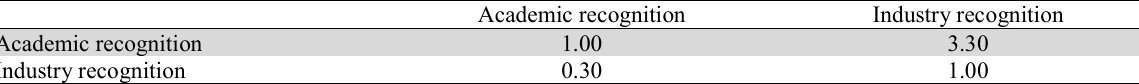
Comparison matrix for comparing the sub-factors of “social recognition” Academic recognition Industry recognition Academic recognition 1.00 3.30 Industry recognition 0.30 1.00